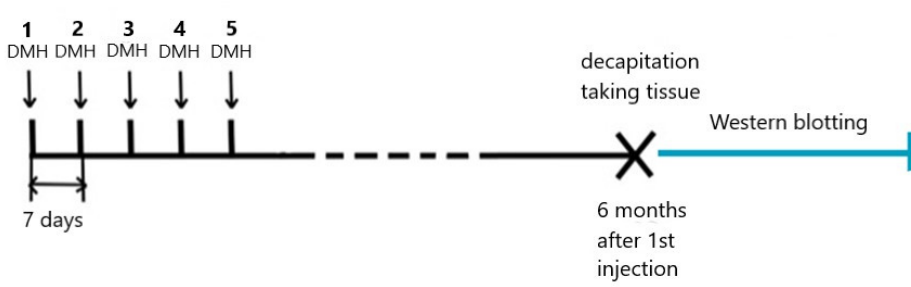
Figure 5. Animal experimental design